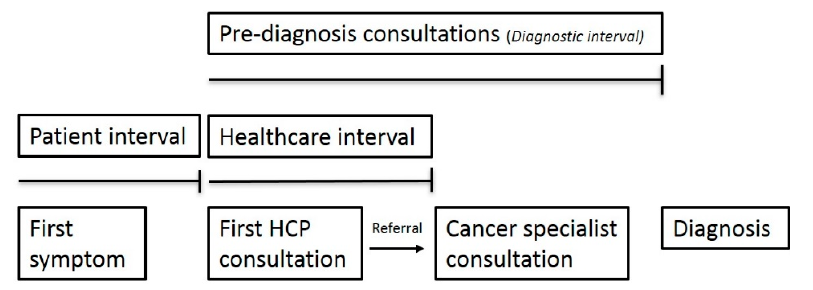
Figure 1. Diagnostic